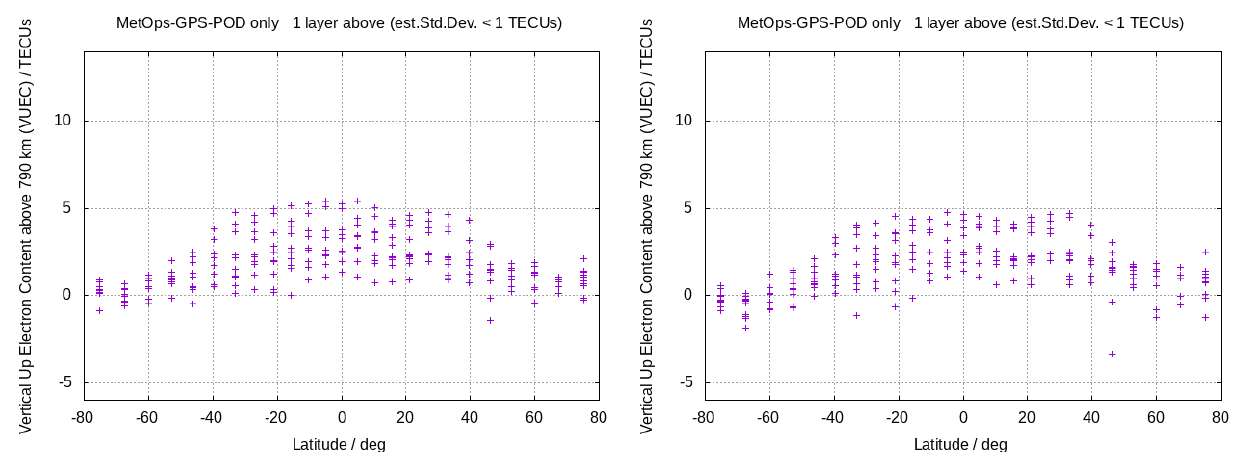
Figure 6. Comparison of the Vertical Upper Electron Content (in TECUs) vs latitude at GPS time 21 h 45 m of day 176 of year 2020, considering 2 layers (1 above MetOp LEO satellites) and MetOp POD GPS measurements only: ( left ) Without receiving antenna corrections and ( right ) with receiving antenna